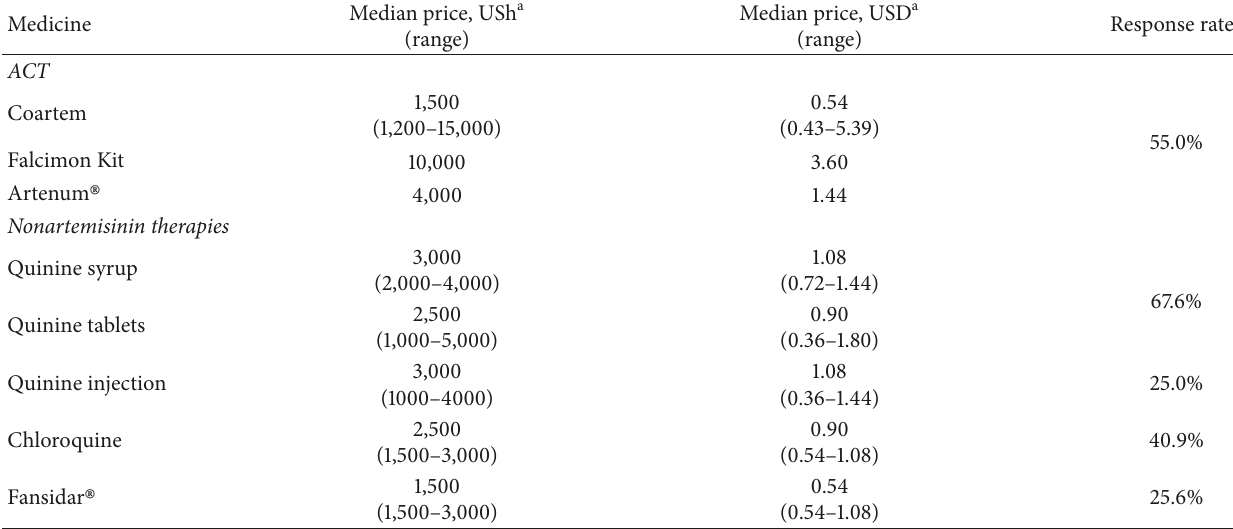
Table 3: Estimated prices for a full antimalarial treatment at participating outlets.